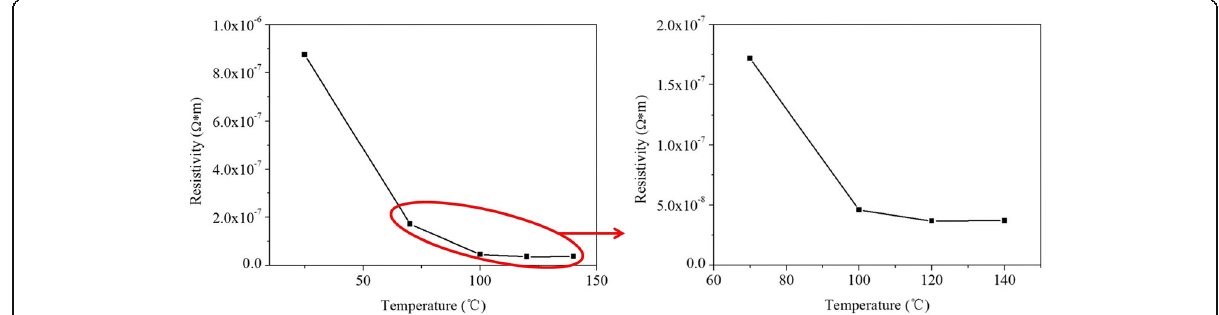
Fig. 7 . Resistivity of silver films heat-treated at different temperatures for 30 min